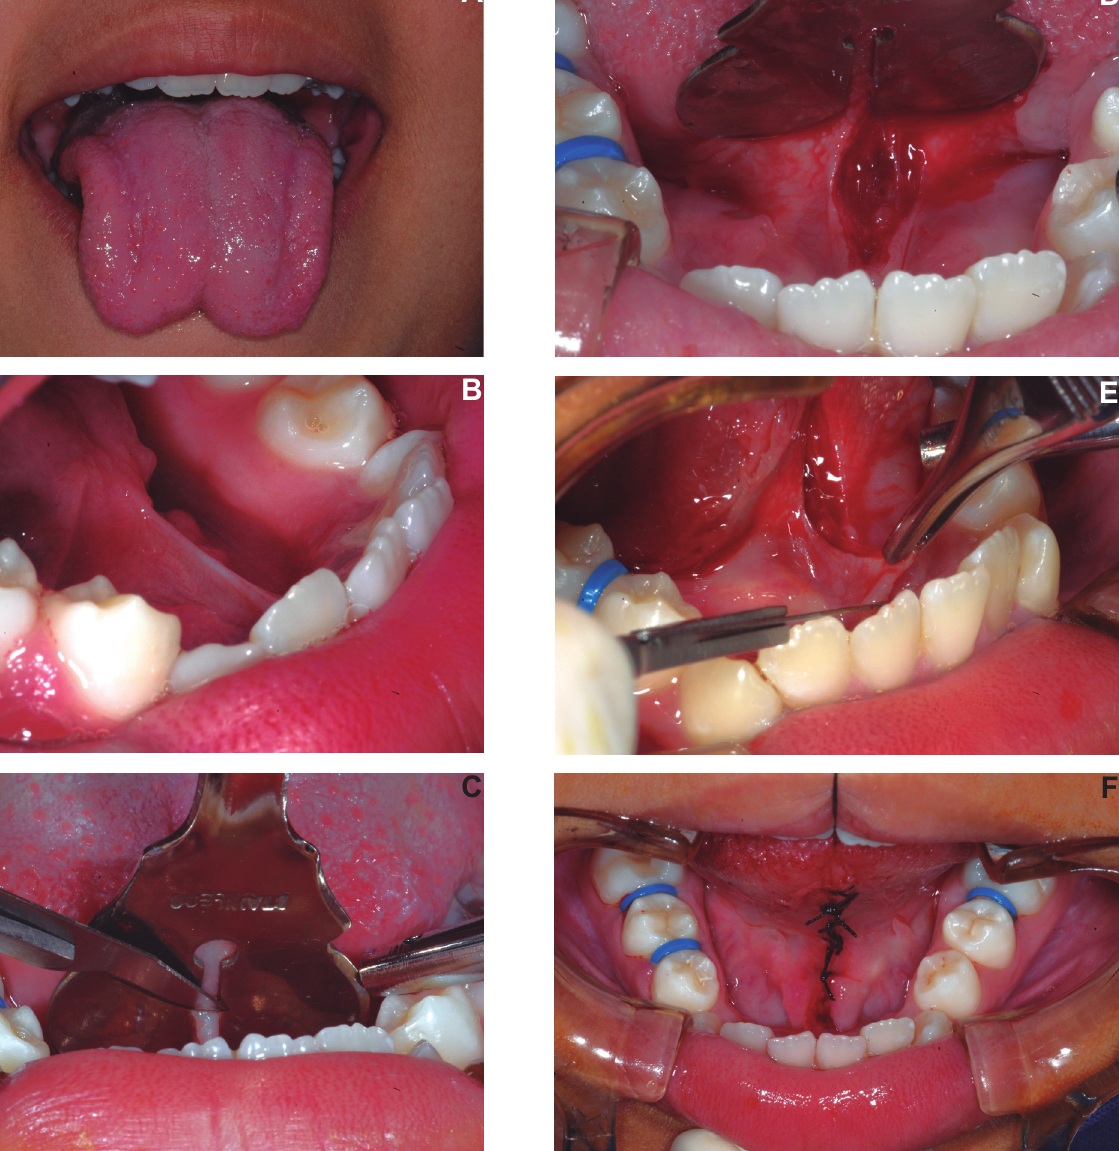
Figure 4- Frenectomy with use of a grooved director. A) Heart-shaped tongue during protrusion. B) Short lingual frenulum with apical insertion. C) Tongue being raised toward the palate with a grooved director. D) Incision from the tip to the base of the tongue following the grooved director. E) Excision of the remaining frenulum. F) Silk sutures placed over the